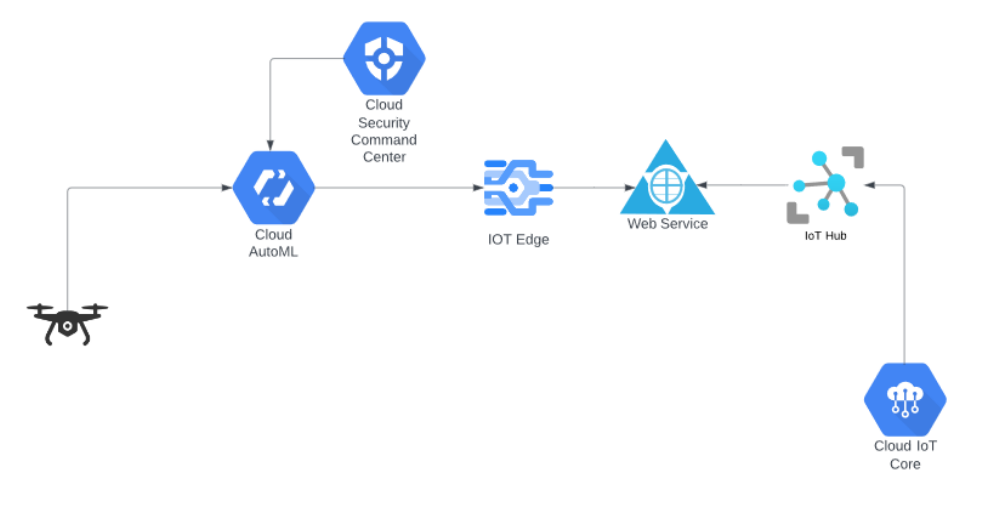
Figure 2. UAV based futuristic patient monitoring and support